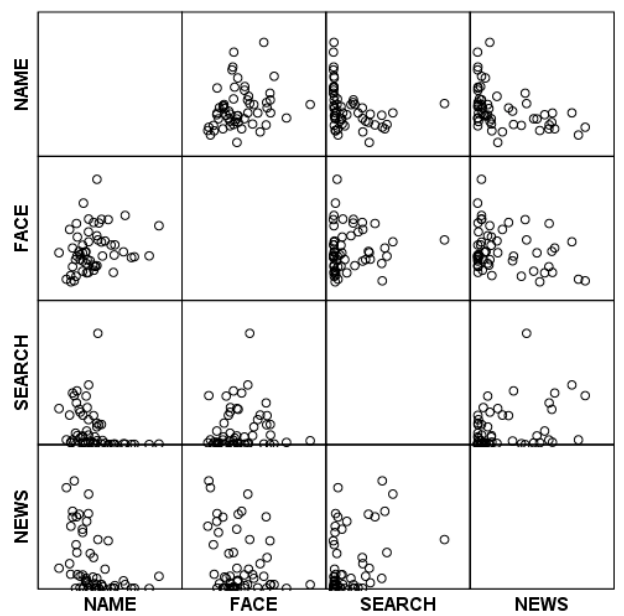
Figure 4. Scatter plot correlation for online searches on Google and Google News for face and name conditions. Table 3. Regression analysis for frequency database (Google searchers and News) with regards face and name recognition.